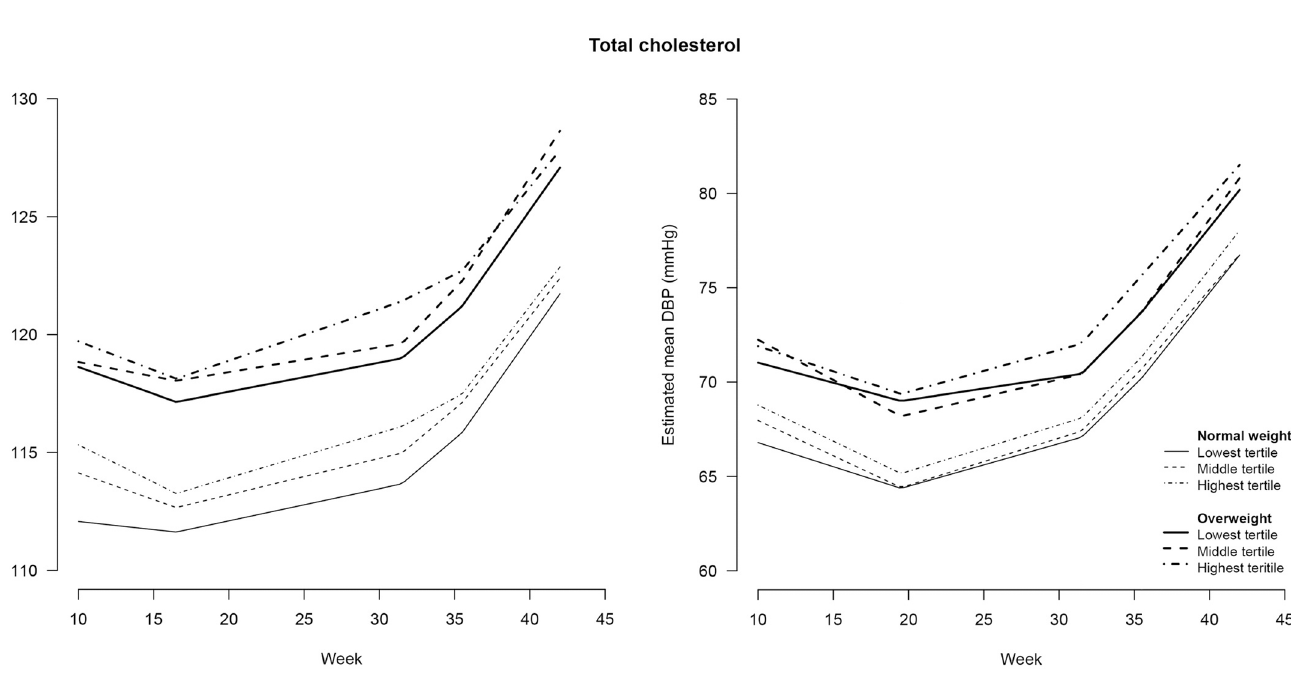
Fig 7. Blood pressure during pregnancy stratified for maternal weight status and tertiles of total cholesterol # . SBP = systolic blood pressure; DBP = diastolicblood pressure. # total cholesterol was determinedin non-fasting blood samples drawn at a medianof 13 (IQR = 12–14)weeks of